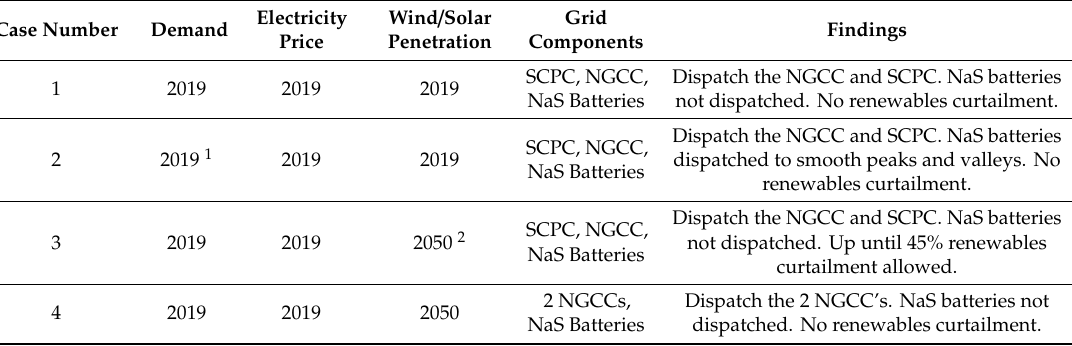
Table 5. Case studies according to their main di ff erences and findings.